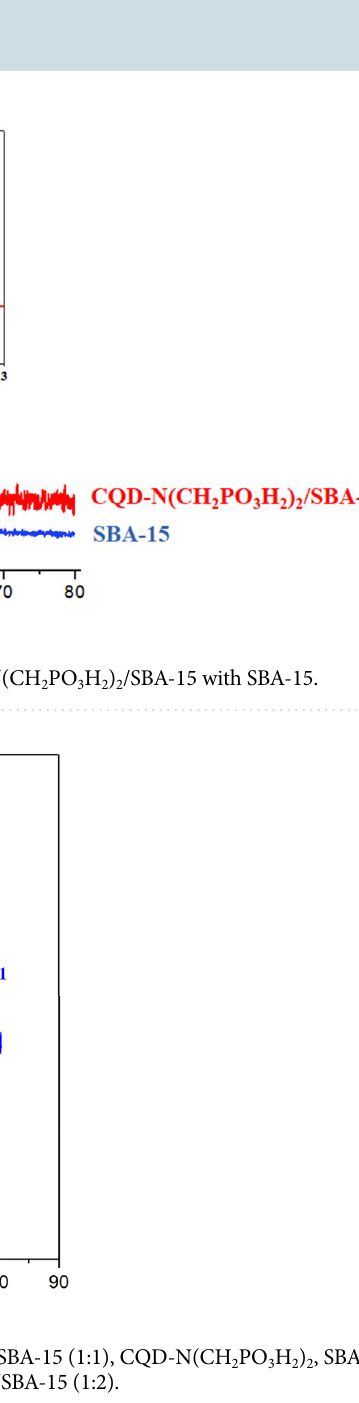
The surface of CQDs-N(CH 2 PO 3 H 2 ) 2 /SBA-15 was determined by SEM images (Fig. 8). SEM images of the catalyst revealed that the particles have not completely agglomerated and particles of observed in tubular nano rod shape of silica template (Fig. 8a,b). In another investigation, the schaffold CQDs-N(CH 2 PO 3 H 2 ) 2 /SBA-15 is composed of C, N, O, Si and P according to the energy dispersive X-ray spectroscopy (EDX) technique (Fig. 8c). Also, distribution of elements including P (red), Si (blue), O (green), N (yellow) and C (orange) on the surface of the catalyst was investigated and verified by SEM-elemental technique (Fig. 8d). Therefore, energy dispersive X-ray spectroscopy (EDX) and SEM-elemental mapping spectroscopy of all the expected elements confirm the uniform distribution of the elements on the surface. The morphology and surface of CQDs-N(CH 2 PO 3 H 2 ) 2 /SBA-15 was determined by TEM analysis (Fig. 9). The TEM images of the CQDs-N(CH 2 PO 3 H 2 ) 2 /SBA-15 were shown to be well fit with the two-dimensional hexagonal meso-structures. Based on these images, the scaffold of mesoporous template has been assembled with carbon